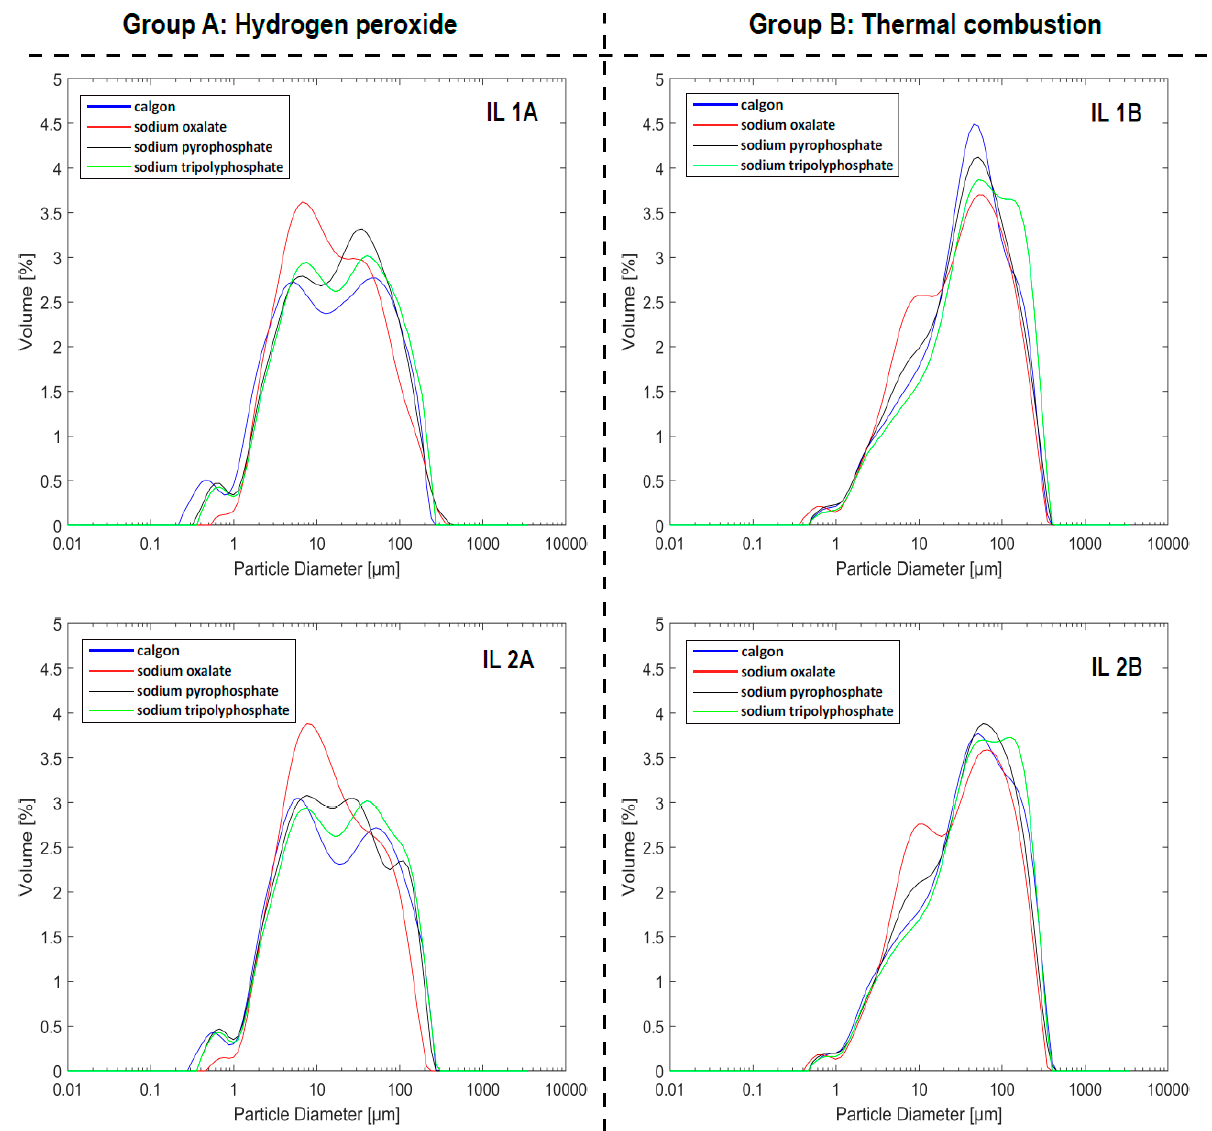
Figure 3. Grain size distribution curves of sediment samples IL 1 and IL 2, with Group A being treated using hydrogen peroxide and Group B with thermal combustion. Each curve represents the average of five measurements.